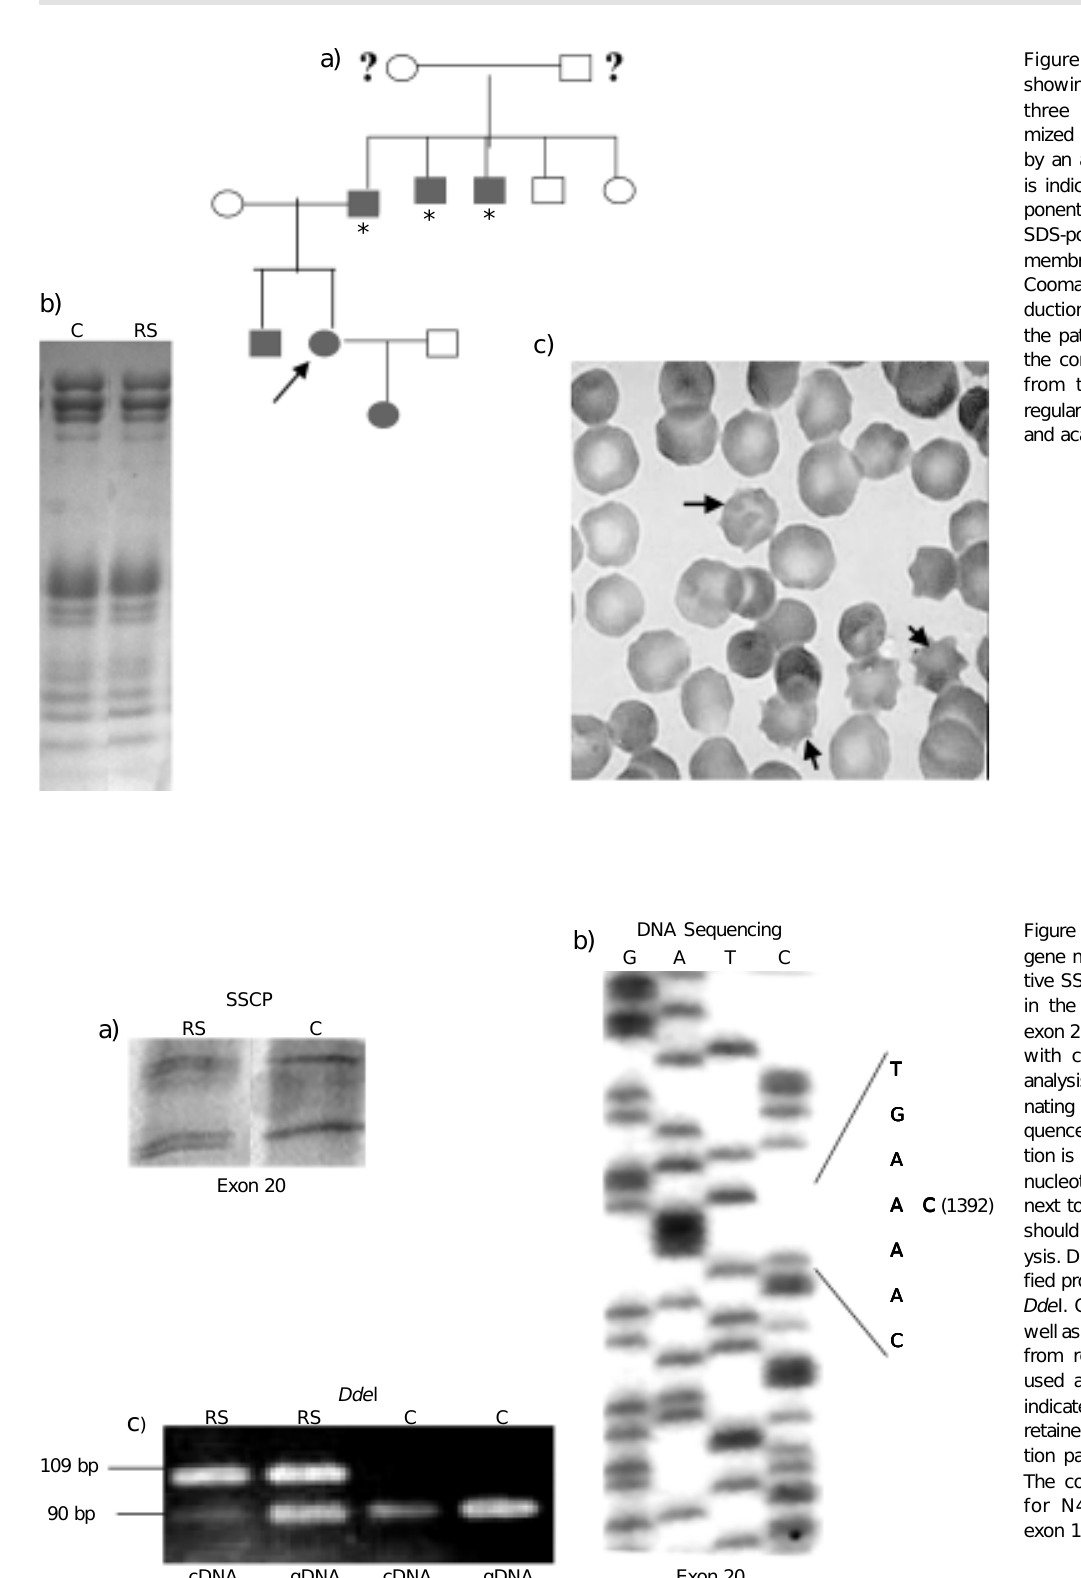
Figure 2. Analysis of ß-spectrin gene mutations. a , Non-radioac- tive SSCP showing a band shift in the amplification product of exon 20 of patient RS compared with control (C). b , Sequence analysis of a mutant clone origi- nating from patient RS. The se- quence in the region of the dele- tion is indicated and the deleted nucleotides appear on the right next to the position where they should be found. c , mRNA anal- ysis. Digestion of exon 11 ampli- fied products of patient RS with Dde I. Genomic DNA (gDNA), as well as cDNA reverse transcribed from reticulocyte mRNA, were used as templates for PCR as indicated. Note that the patient retained a heterozygous diges- tion pattern at the cDNA level. The control (C) is homozygous for N439S polymorphism in exon